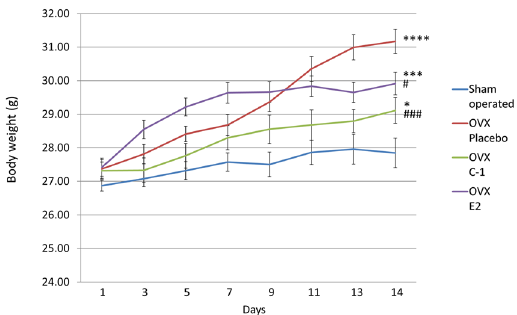
Figure 5. Change in body weight in sham-operated mice and ovariectomized mice administered placebo, C-1, or E2. Mice administered C-1 or E2 had significantly lower body weight at day 14 than those administered placebo. Error bars represent standard errors of the mean. Post-hoc LSD test: * P < 0.05 as compared with sham- operated mice; *** P < 0.001 as compared with sham-operated mice; **** P < 0.0001 as compared with sham- operated mice; # P < 0.05 as compared with placebo-administered mice; ### P < 0.001 as compared with placebo- administered